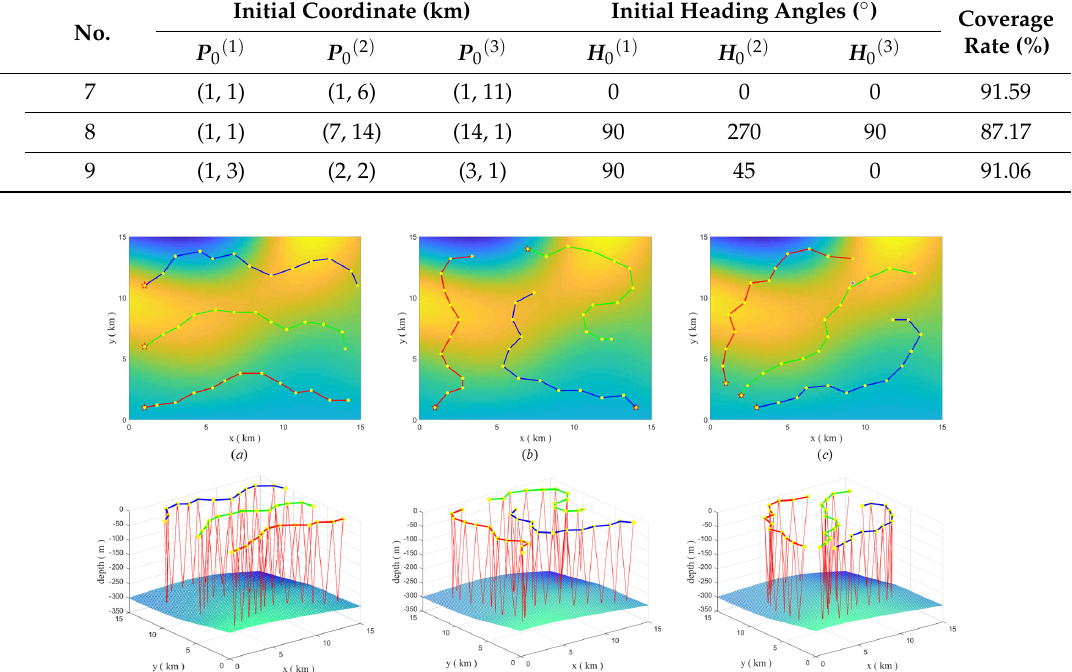
Figure 7. The MGCPP − ACO algorithm path planning results in scenario 1 (where ( a – c ) are 2D plane trajectories, and ( d – f ) are 3D space trajectories).